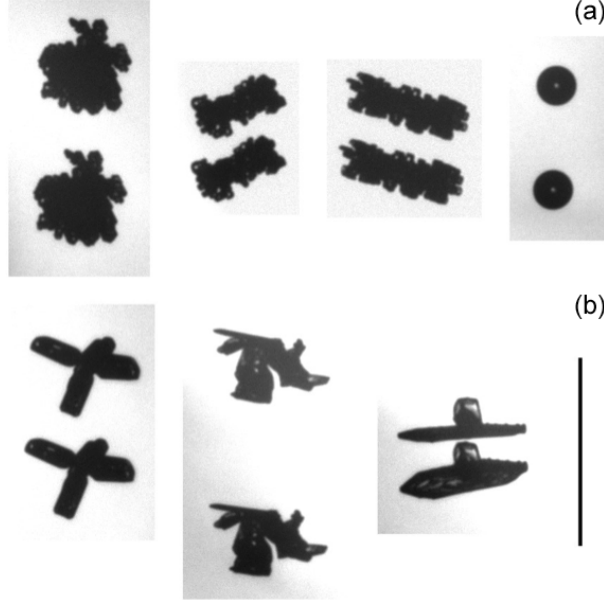
Figure 9. Example side-view images of doubly exposed falling ice particles. The fall speed is determined from the vertical sep- aration of the two instances of the particle on the same im- age. Panel (a) shows measurements from 19 October 2014; panel (b) shows measurements from 23 October 2014. For refer- ence, a size bar with length corresponding to 1mm is